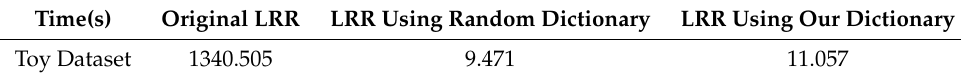
Figure 10. ROC curves and AUC values achieved by LRR using different dictionaries for the toy dataset. Table 3. Computation times of LRR using different dictionaries for the toy